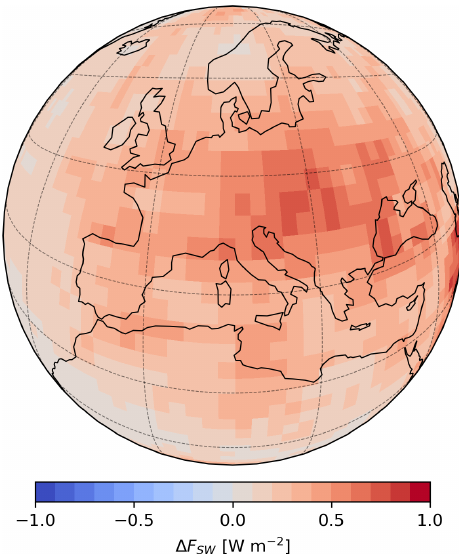
Figure 7. Difference in monthly mean clear-sky shortwave radia- tion (May 2020) at the surface between RED and BASE simulation. Positive (red) values indicate more incoming radiation at the surface due to less absorption and backscattering in the “lockdown” atmo- sphere than in the baseline scenario. Note that we used a common reduction factor for emissions from countries outside Europe.